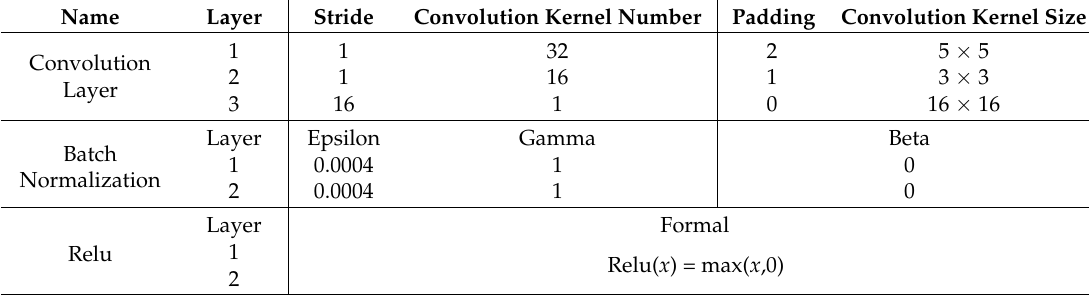
Table 1. Envelope recognition binarized convolution neural network (BCNN) parameters.